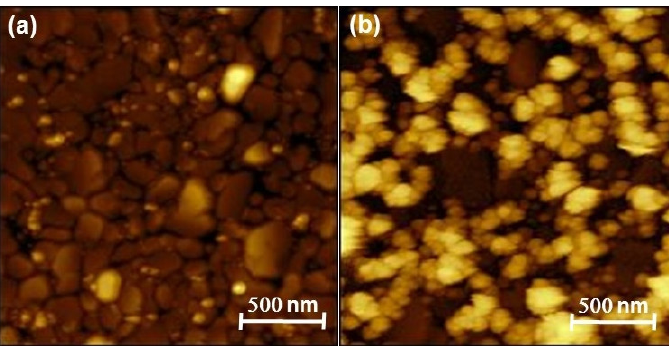
Figure 7. SEM image ( a ) and energy dispersive X-ray spectroscopy (EDS) mapping showing ( b ) Au and ( c ) Pt chemical contrasts for the Pt layer deposited on the gold-coated glass slide after 5 cycles of Te deposition and Pt replacement. Nanomaterials 2018 , 8 , x FOR PEER REVIEW